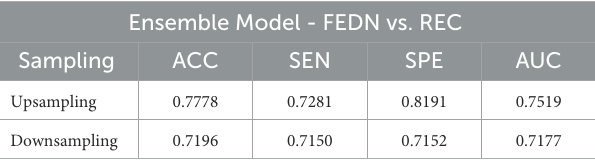
TABLE 3 Ensemble model performance under FEDN vs. REC